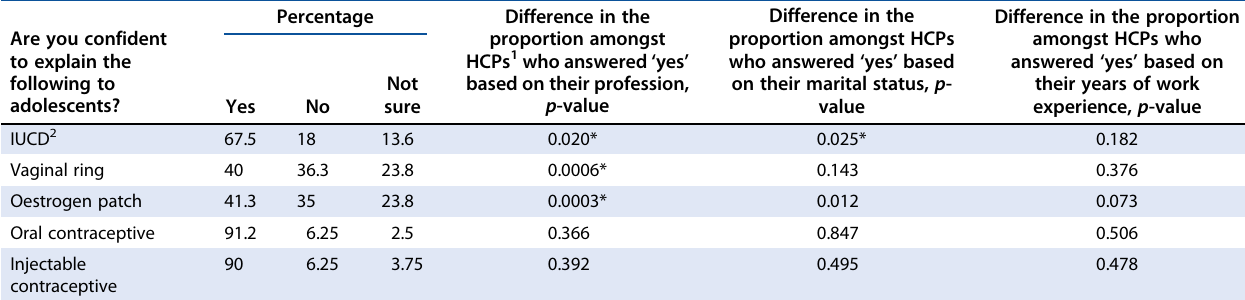
Table 2: Healthcare providers ’ knowledge of adolescents ’ contraceptive use in Mahalapye, Botswana, November – December 2016